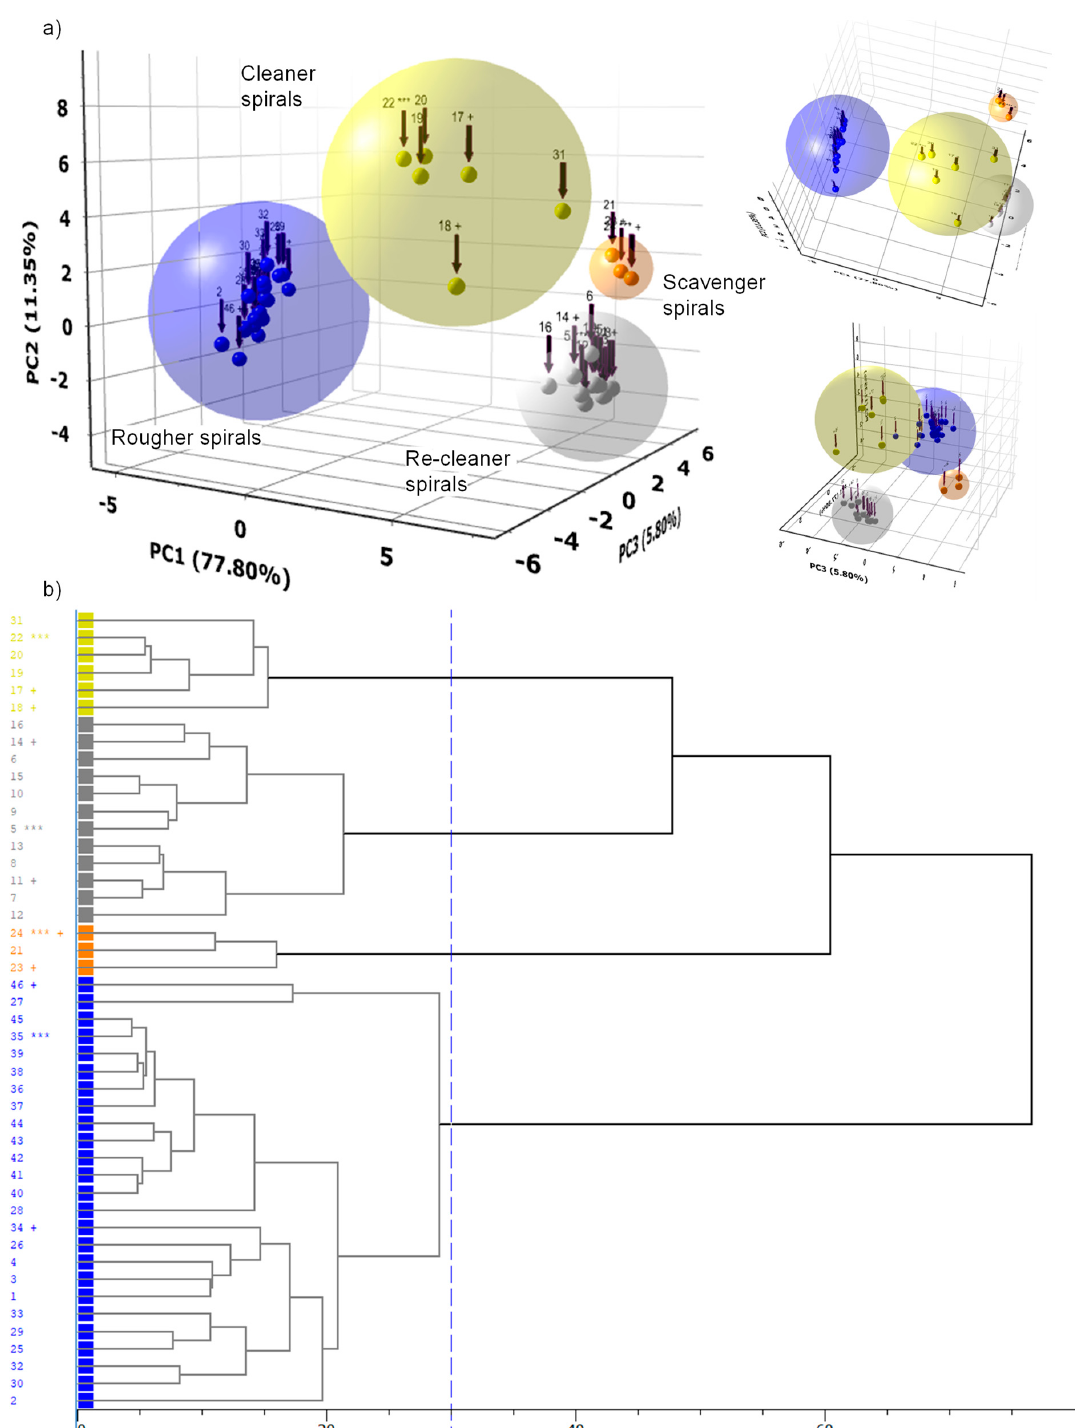
Figure 3. ( a ) 3D PCA score plot for the cluster analysis of 46 samples from a wet concentration plant, illustrated in three views. The three axes represent the three most important principal components explaining a major part of the total overall variance in the correlation matrix. The covered total variance is 94.95%. ( b ) Corresponding dendrogram with agglomerative hierarchical cluster analysis showing the scans in different classes defined by their similarity and vertical cut-off lines. Each dataset is connected by a tie bar to another dataset or to a cluster. The horizontal length of the tie bars is proportional to the dissimilarity ( x -axis). The color of the spheres indicates the cluster they belong to. The *** after a scan name indicates the most representative scan of a cluster. The + after a scan name indicates the two most different (outlying) scans within one cluster. Each dot represents one measurement. All measurements are compared with each other to find